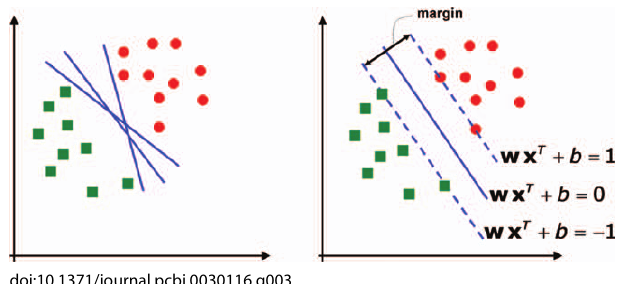
Figure 3. Support Vector Machines Class Boundaries Two-dimensional data points belonging to two different classes (circles and squares) are shown in the left panel. The right panel shows the maximum-margin decision boundary implemented by the SVMs. Samples along the dashed lines are called